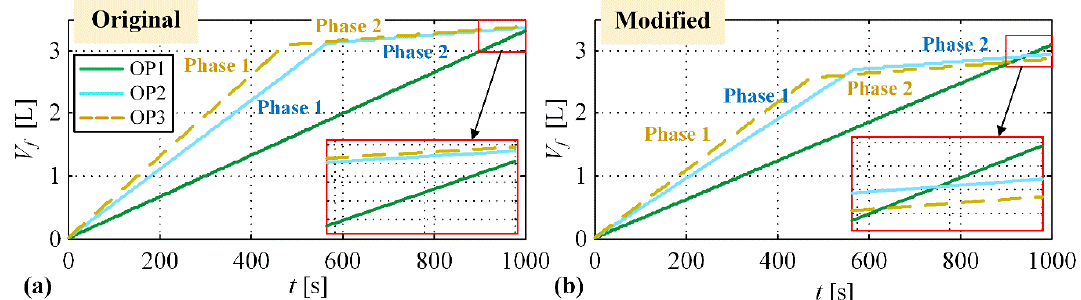
Figure 13. Comparative cumulative fuel consumption time profiles for different operating scenarios for original ( a ) and modified engine fuel consumption characteristics ( b ).